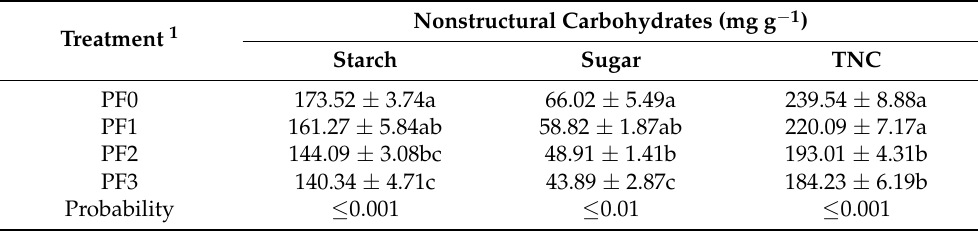
Table 3. Concentration of starch, sugar and total nonstructural carbohydrates (TNC) in roots of S. sesban plants subjected to different pruning frequencies.